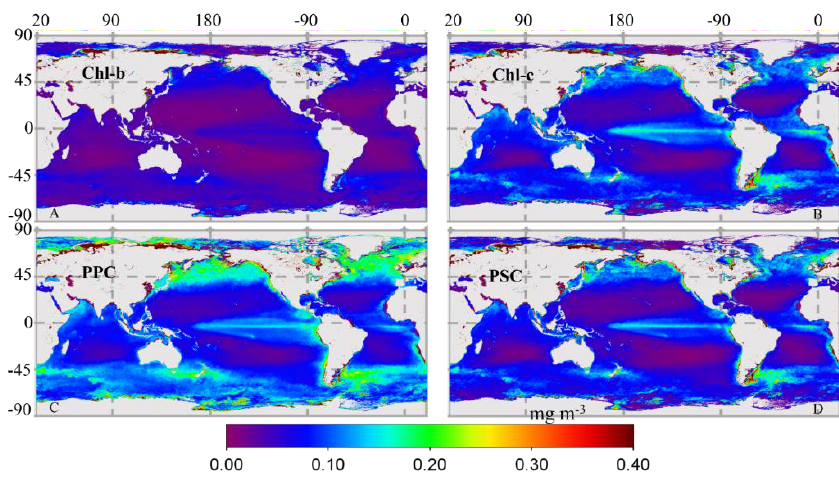
imagery using NASA standard algorithm OC4E ( A ) and MuPI model ( B ). The locations ( o ) of in situ Chl-a and MERIS R rs (λ) matchups for further comparison of OC4E and MuPI were plotted on the OC4E Chl-a map. C : Chlorophyll a concentration (Chl-a) from in situ measurements and from those estimated from matchups of MERIS R rs (λ) using OC4E and MuPI algorithms with mean UAPD of 48.8% and RMSE of 4.51 mg∙m −3 for OC4E and mean UAPD of 49.3% and RMSE of 4.05 mg∙m −3 for MuPI.